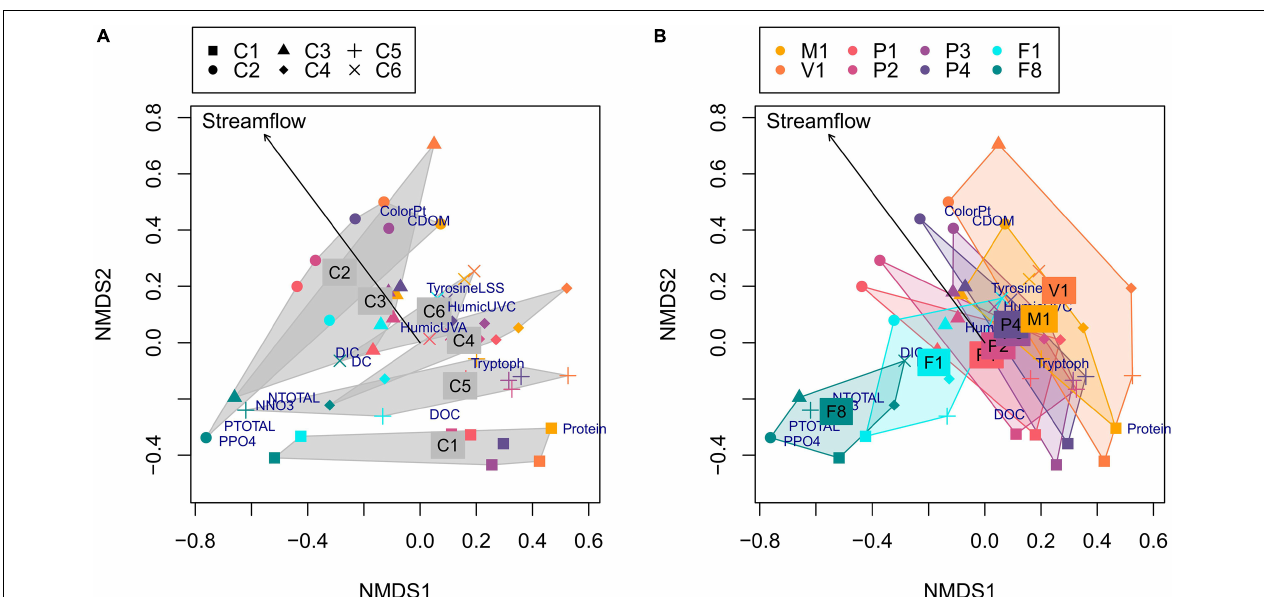
FIGURE 4 | Non-metric dimensional scaling (NMDS) ordination of all samples based on nutrients and DOM descriptors (symbol colors indicate the different sampling sites and shapes show the different campaigns). Labels indicate the nutrients and DOM descriptors. The left panel (A) shows hulls for the Campaign groups, labeled at the position of the average group scores. All the hulls except or C3 were significantly smaller than those produced by random groups. The right panel (B) shows hulls for the Site groups, labeled at the position of the average group scores. Only the hull for F8 is significantly smaller than those produced by random groups (see Supplementary Table 4 ). The arrow corresponds to streamflow values fitted to the ordination ( r 2 = 0.1902, p = 0.01).